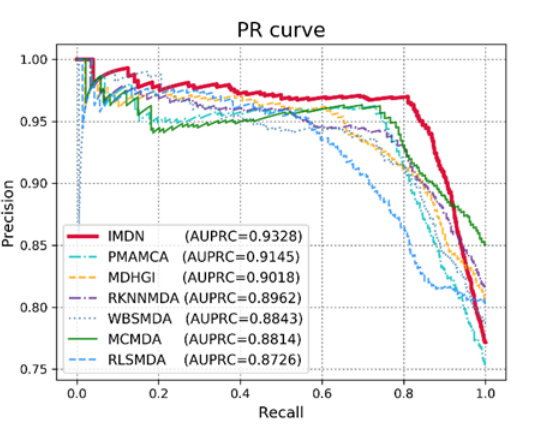
Figure 3. Performance comparisons based on global local leave-one-out cross-validations (LOOCV) and local LOOCV in terms of area under the curve (AUC) scores. As is shown, IMDN achieved AUCs of 0.9162 and 0.8965, respectively, outperforming the previous models.